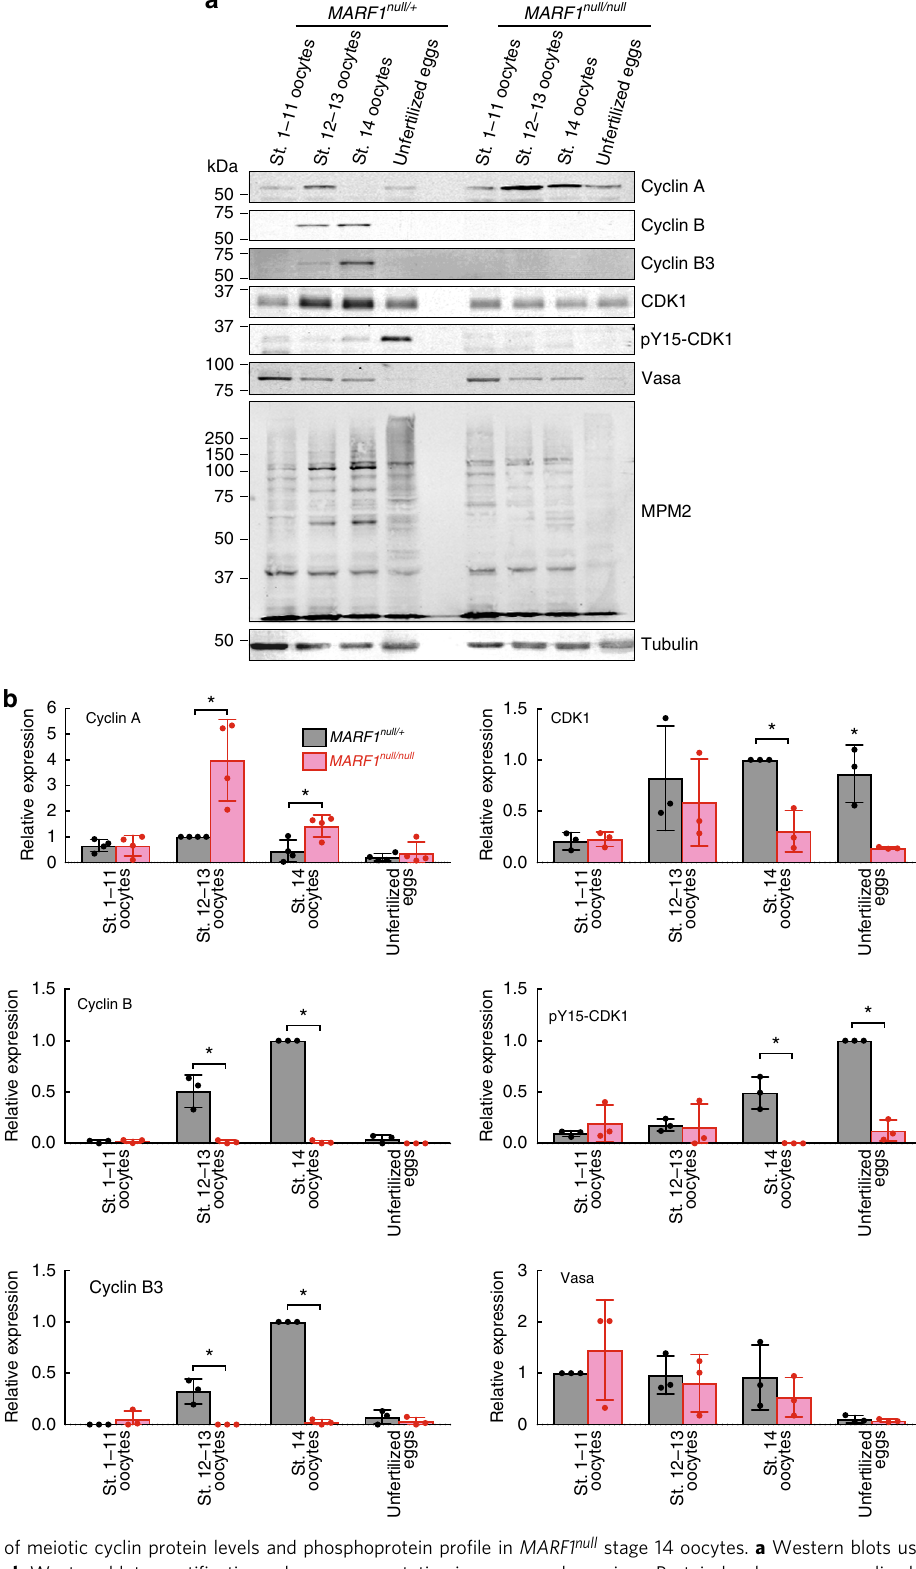
Fig. 5 Dysregulation of meiotic cyclin protein levels and phosphoprotein pro fi le in MARF1 null stage 14 oocytes. a Western blots using dissected oocytes and unfertilized eggs. b Western blot quanti fi cation, whose representative images are shown in a . Protein levels were normalized to that in control ( MARF1 null/ + ) oocyte stage showing the highest expression (Stages 1 – 11 for Vasa. Stages 12 – 13 for Cyclin A. Stage 14 for Cyclin B, Cyclin B3, and CDK1. Unfertilized eggs for pY15-CDK1). Mean ± SD ( n = 4 for CycA and n = 3 for all the others). P -value < 0.05 (Student ’ s t -test) are indicated by